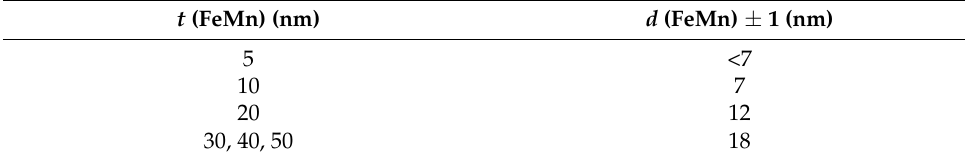
Table 2. Average grain sizes of the FeMn (111) phase at various thicknesses of the layer. t (FeMn)